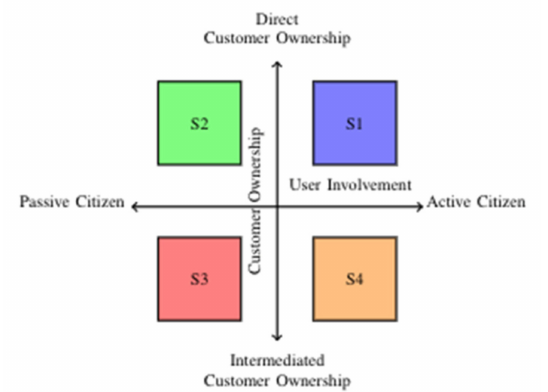
Figure 6. Future scenarios based on customer ownership and user involvement.